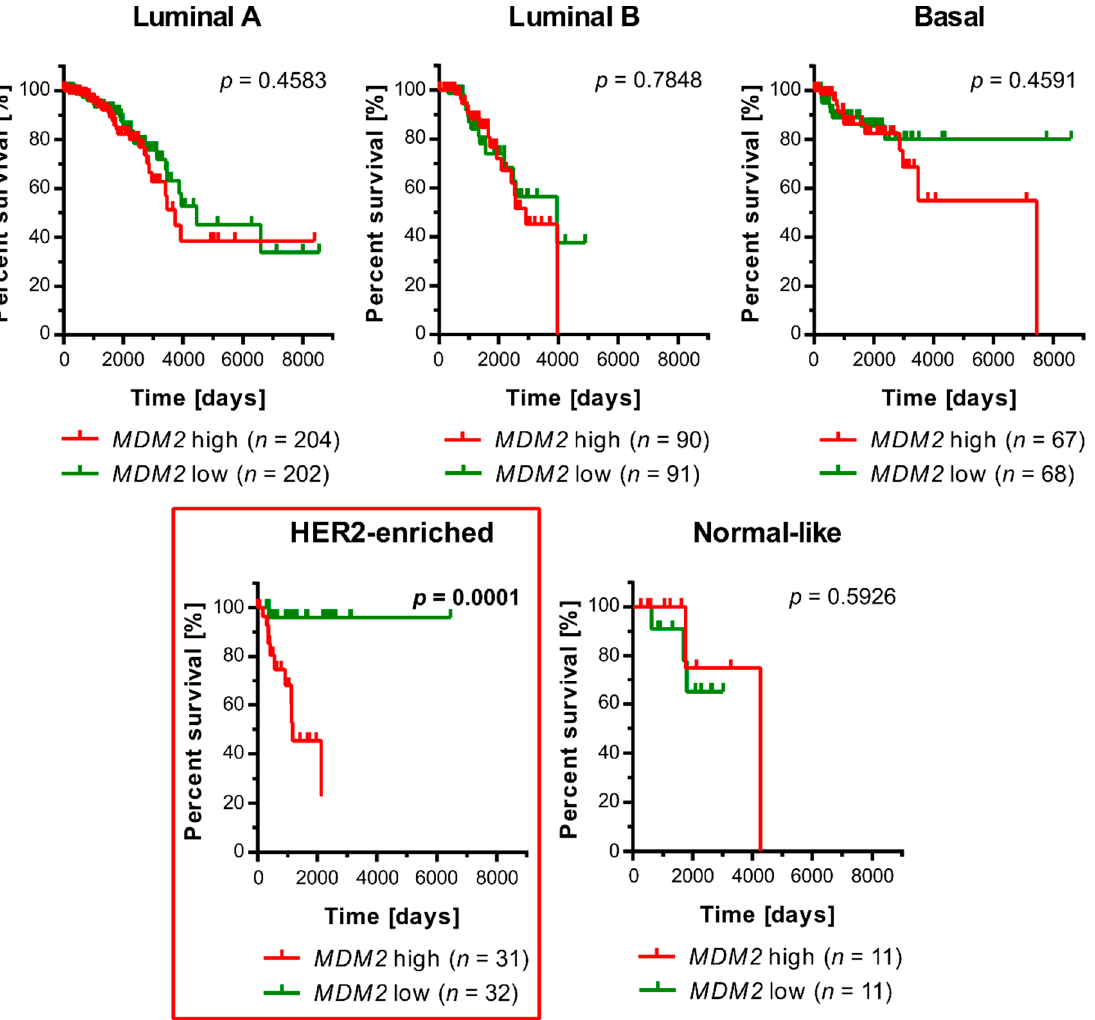
Figure 1. Kaplan–Meier survival curves for overall survival of TCGA breast cancer patients divided by molecular subtypes of breast cancer with high or low MDM2 gene expression. The log-rank test showed a statistically significant difference between the patient survival curves for the HER2-enriched subtype (red box). Patients were assigned to groups with high or low MDM2 transcript levels based on the median value specific to each subtype.